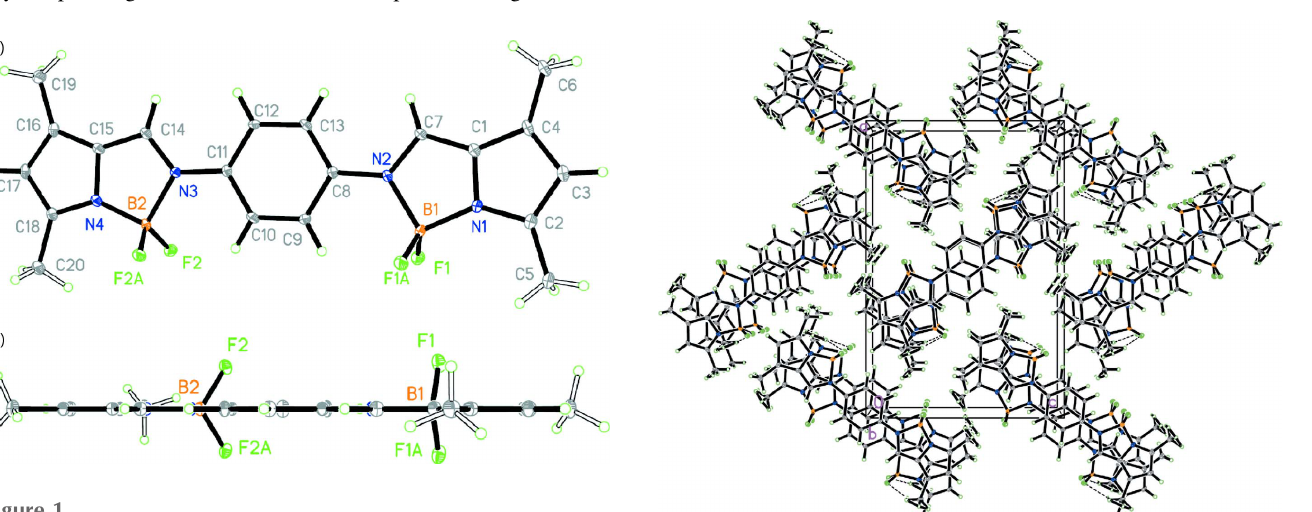
Figure 1 ORTEP diagrams for the title compound, ( a ) top view and ( b ) side view, with displacement ellipsoids drawn at the 30% probability